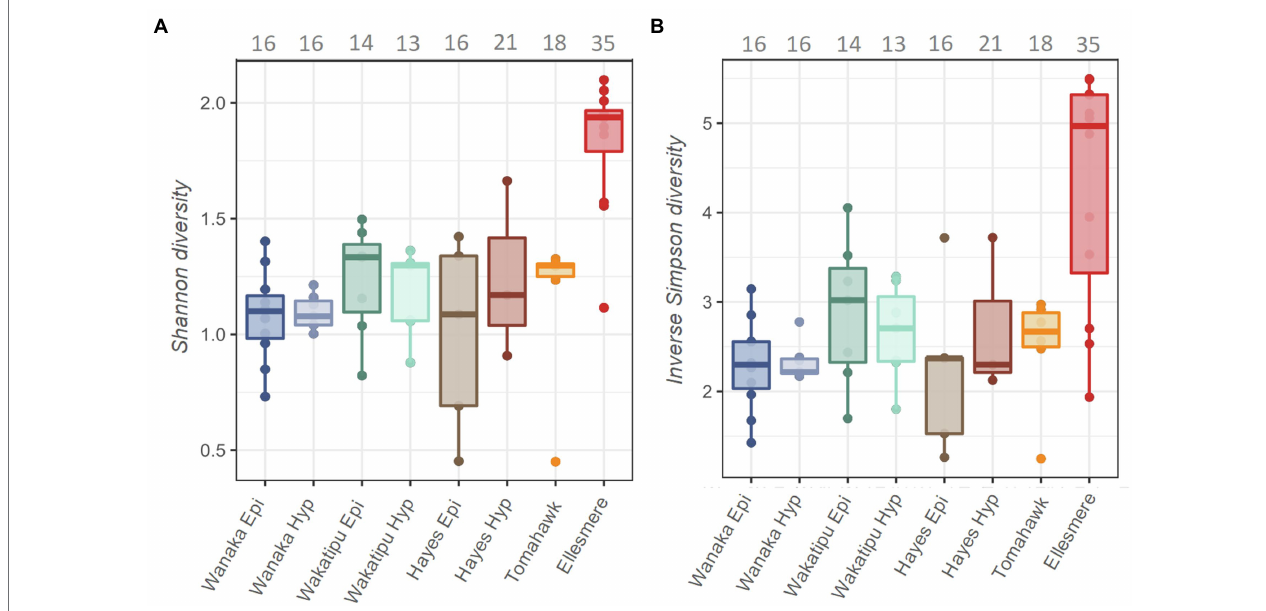
FIGURE 3 | Shannon (A) and Inverse Simpson (B) alpha diversity estimates for the five study lakes, including samples from February 2018 to February 2019. Grey numbers above the plots indicate the total number of picocyanobacterial amplicon sequence variants (ASVs) in each lake over the 12-month period, prior to filtering and